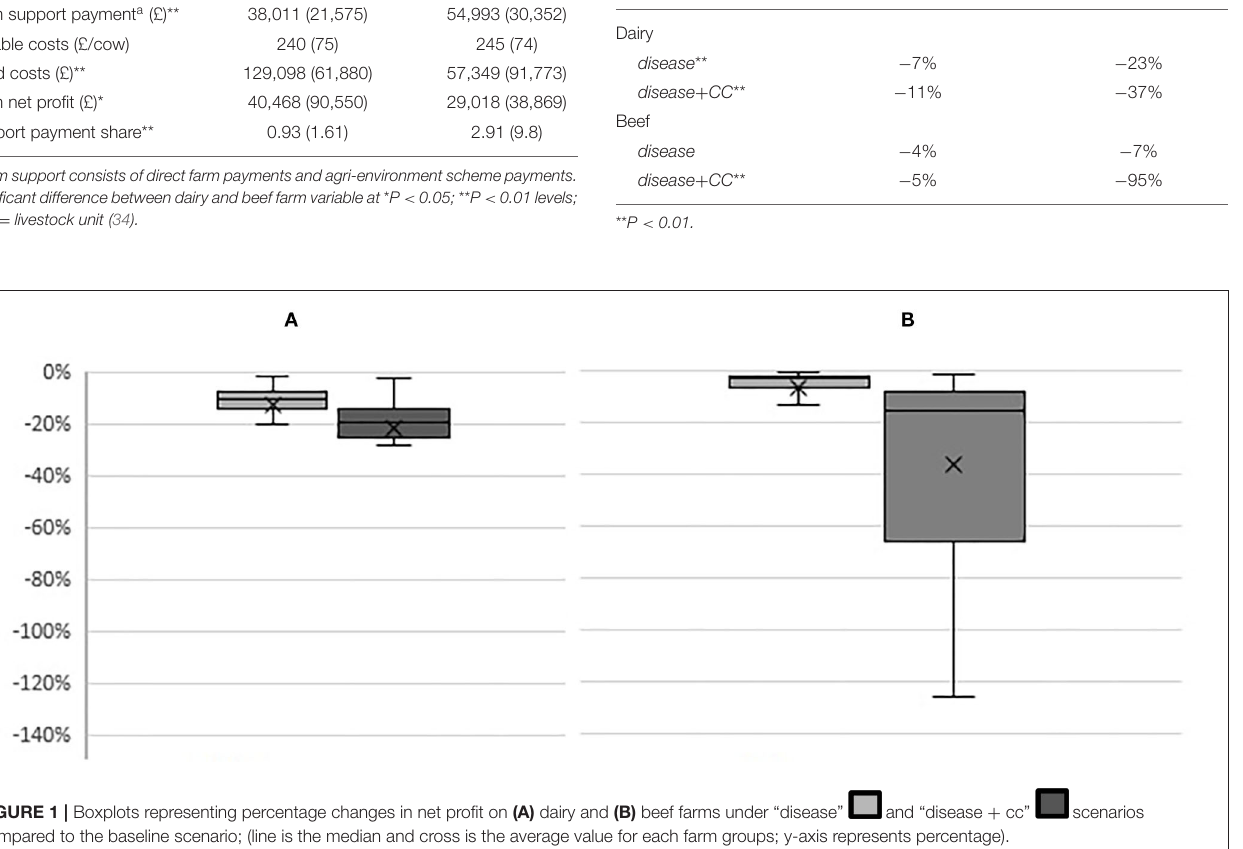
Frontiers in Veterinary Science |